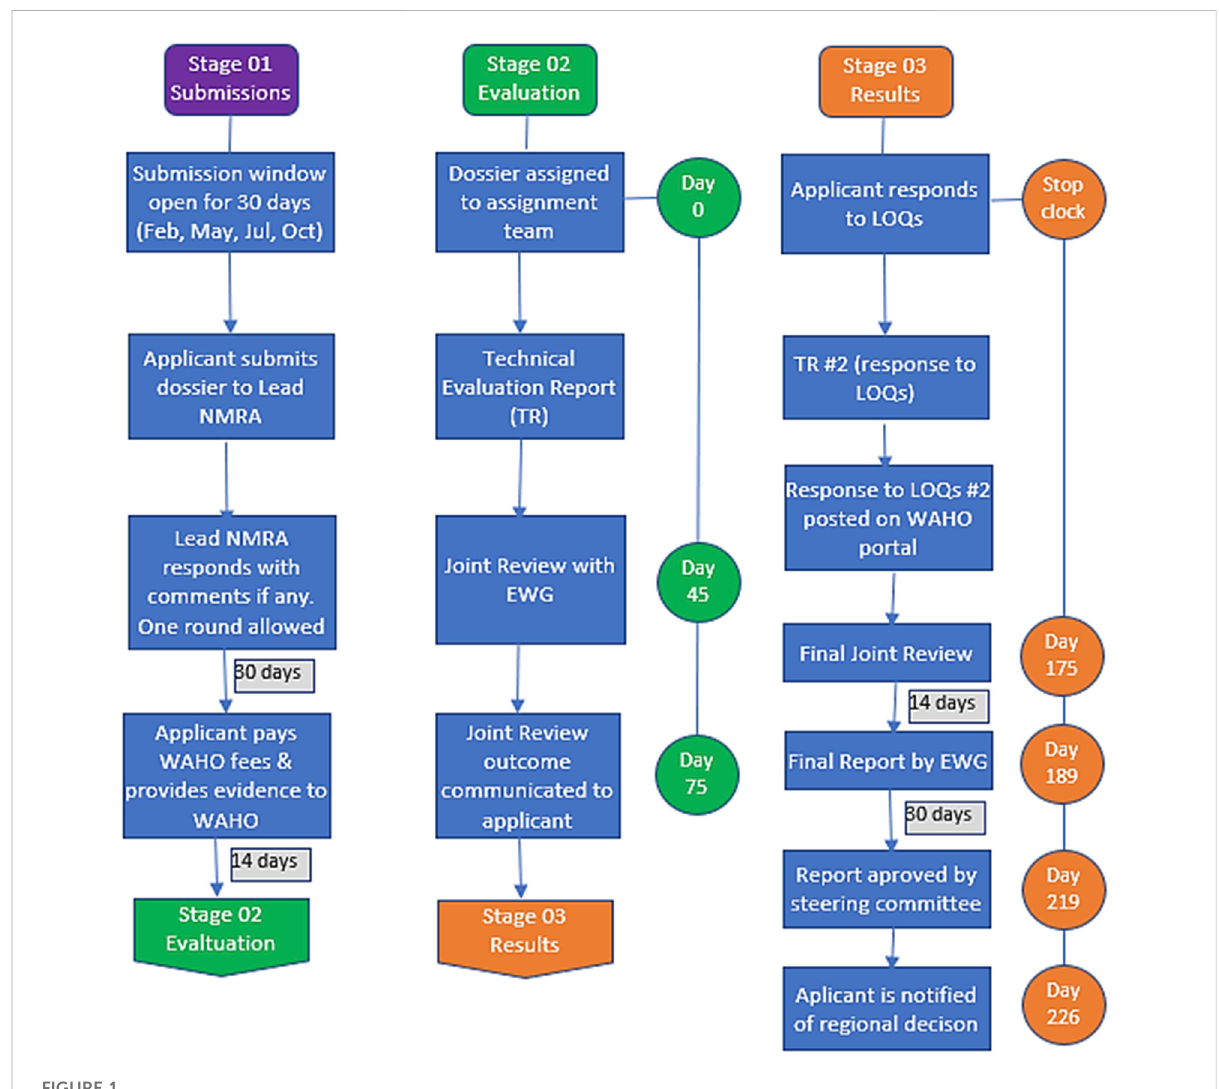
FIGURE 1 The WA-MRH joint assessment